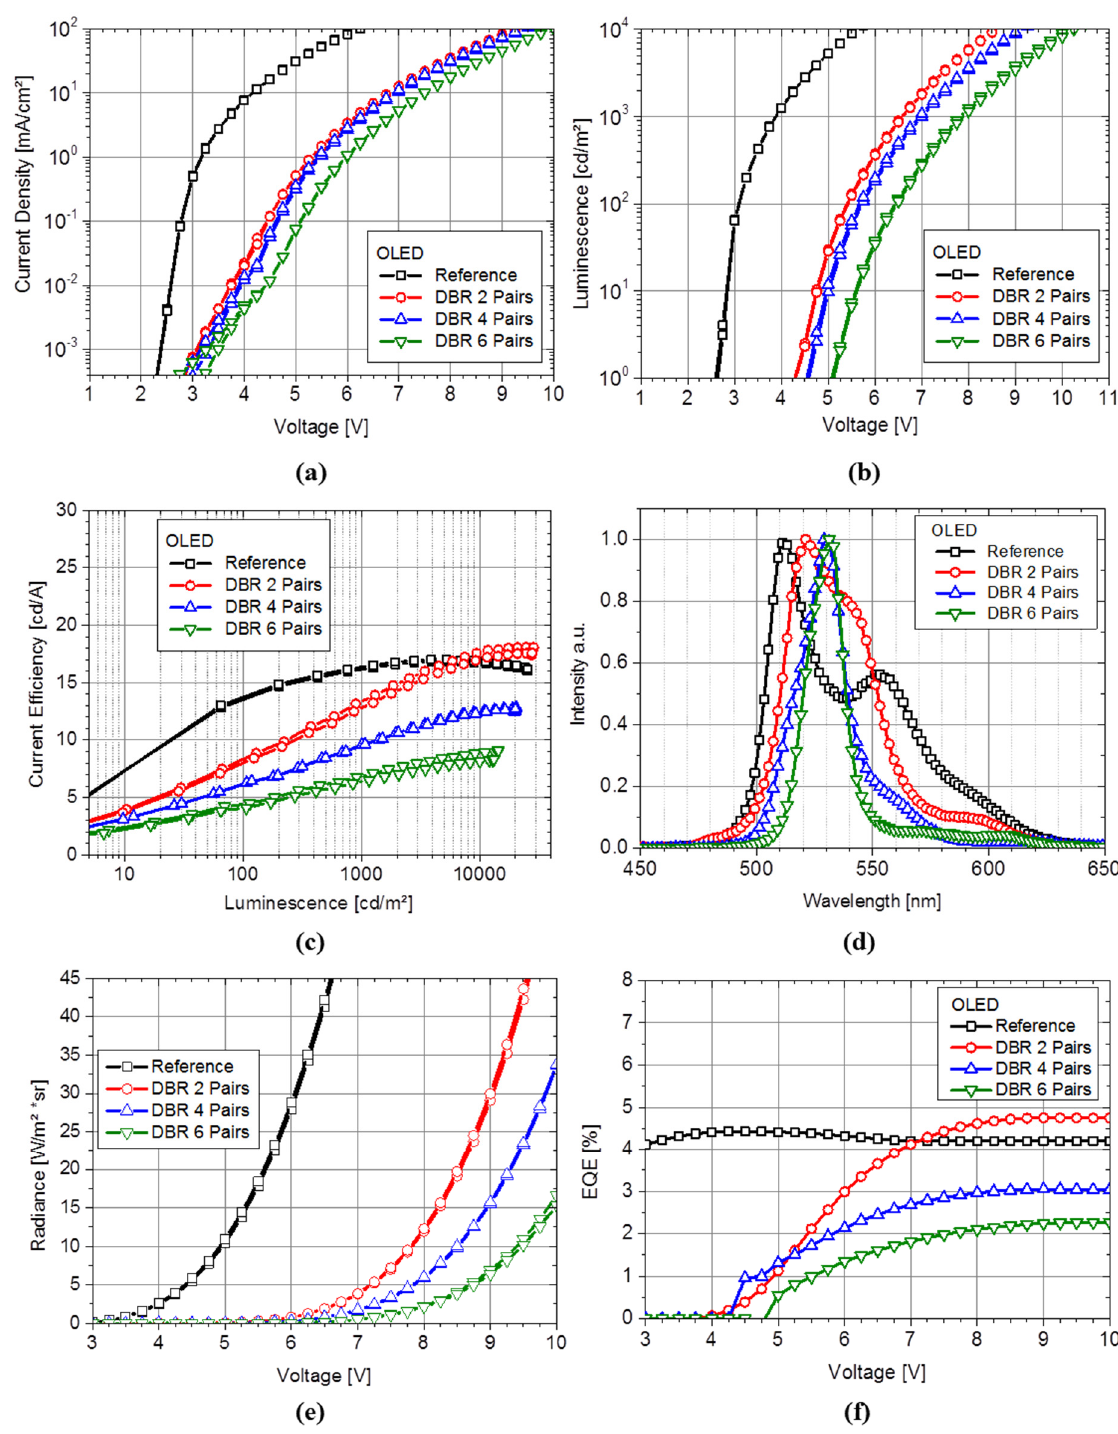
Figure 1. ( a ) Current density to voltage curve ( J-V curve) of all devices; ( b ) determined luminance characteristic of the devices; ( c ) current efficacy vs. luminance and ( d ) the emission spectra of the devices in variation of the mirror pair number measured perpendicular to the OLED surface. Figure ( e ) and ( f ) show the radiometric values: ( e ) the radiance depending on voltage and ( f ) the external quantum